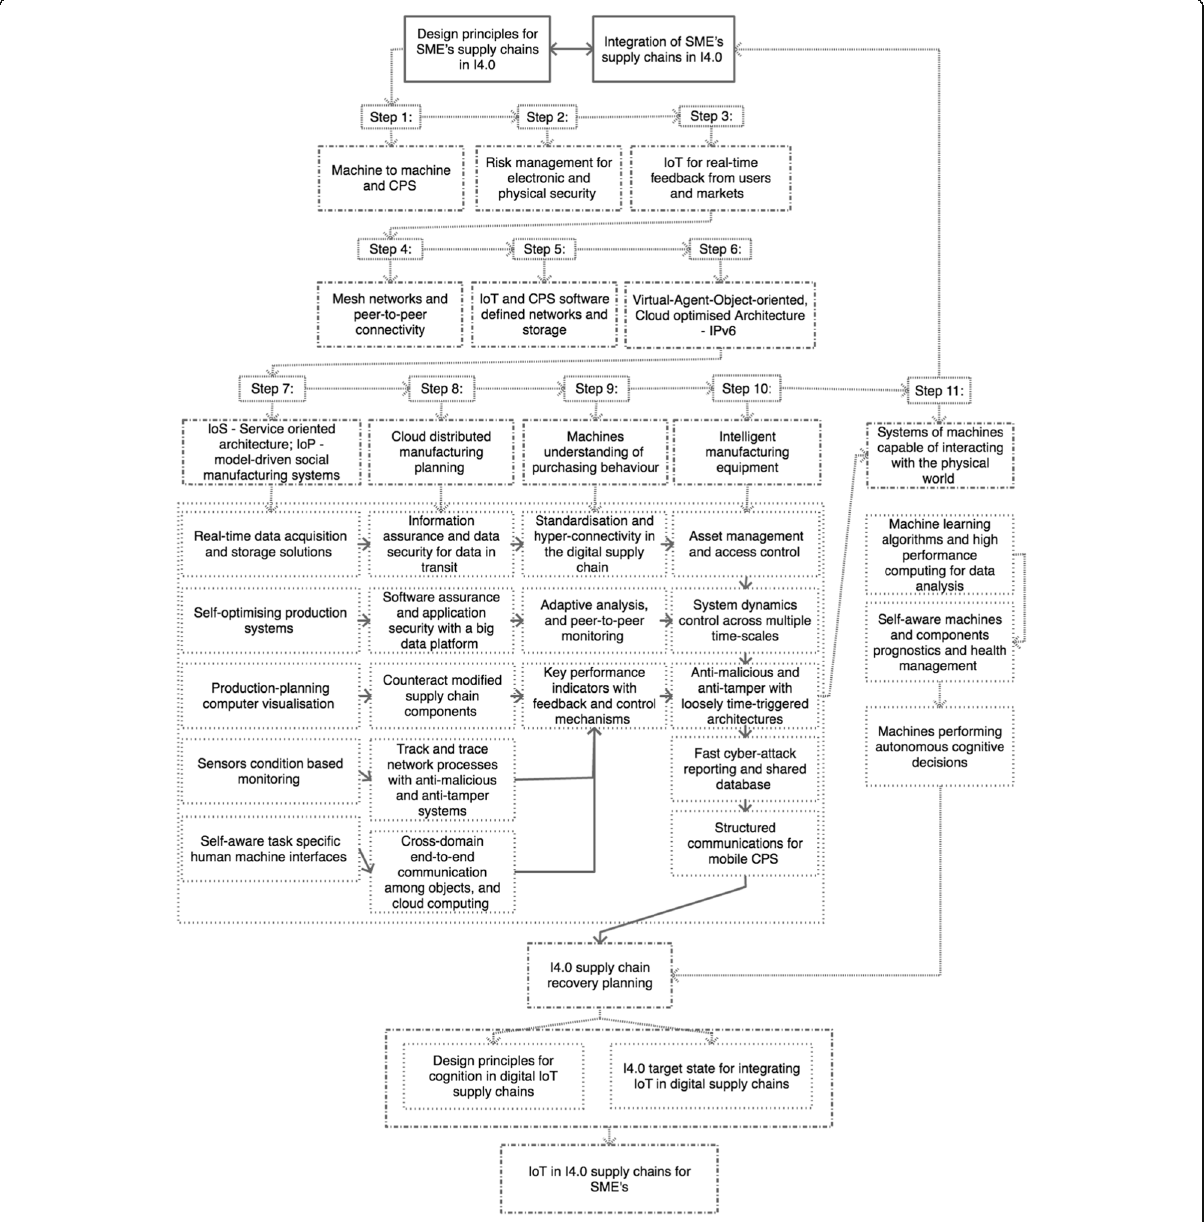
Fig. 3 Analytical framework based on taxonomic/cladistic format: transformational roadmap for supply chain integration in